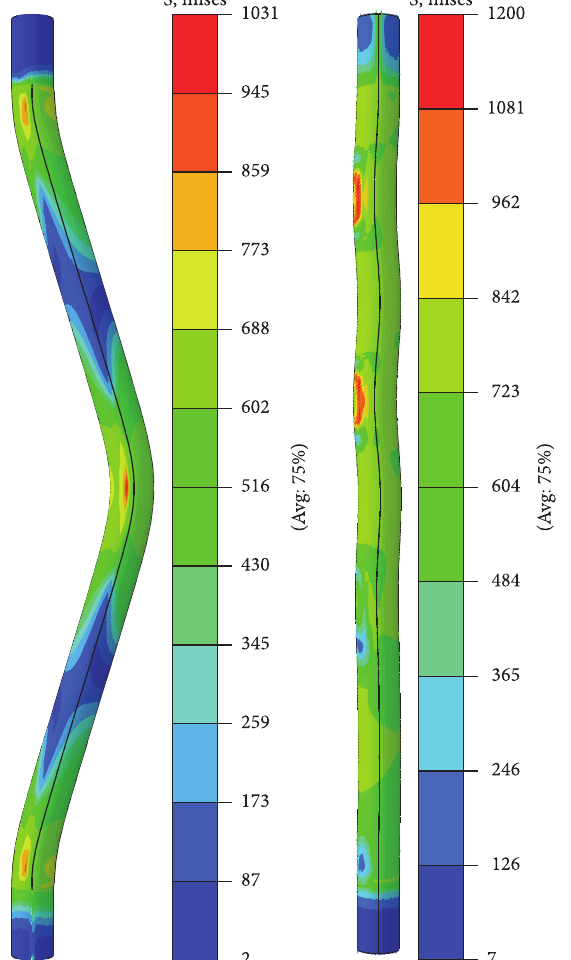
Figure 5: Buckled shapes of the 𝑙/𝑑 = 20 bar with initial imperfection of 0.14mm (see Table 1), from Case 1 , showing, on the left, the bar with plastic properties of x ∗ : 𝜎 0 = 493.0 MPa, 𝑘 = 413.0 MPa, and 𝑛 = 0.3303 , buckled in the 1st mode, 𝑓 = 2.666 , and, on the right, the bar with plastic properties of 2nd evaluation of 𝑓 : 𝜎 0 = 600.0 MPa, 𝑘 = 400.0 MPa, and 𝑛 = 0.3500 , buckled in a higher mode, 𝑓 = 6.1 × 10 2 . See Figure 6 and Table 2 for more details. The contour plots show Mises stress in MPa.